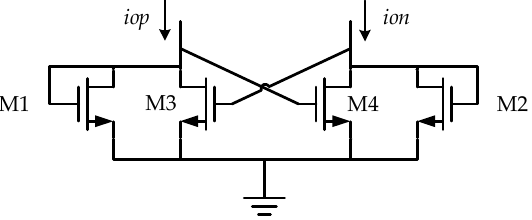
Figure 12. Positive feedback loop of hysteretic comparator.